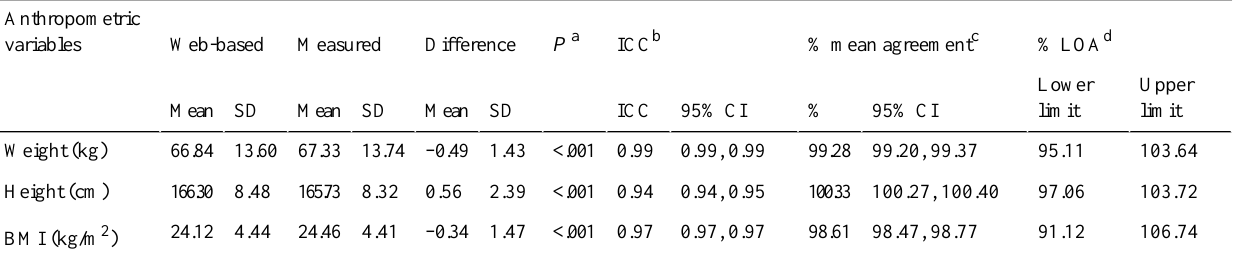
Table 2. Validity indicators of weight, height, and body mass index (BMI) including intraclass correlation coefficient (ICC) between the Web-based self-report and measurement at the clinical examination, Bland–Altman mean agreement, and limits of agreement (LOA) from the NutriNet-Santé Study, 2012, France (N=2513).